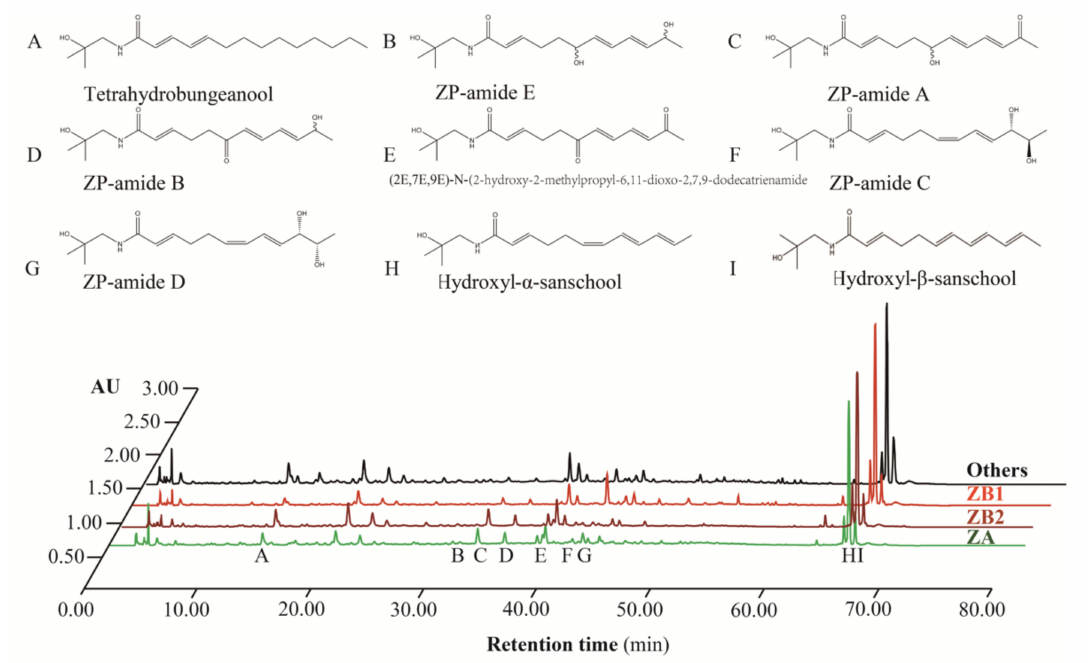
Figure 2. The relative abundance of alkylamides in different prickly ash species. AU represents absorbance unit; the peaks without labels indicate non alkylamide com- ponents; ZP in alkylamides stands for Z. piperitum ; ZA represents Z. armatum ; ZB1 samples are derived from Z. bungeanum from Hancheng; ZB2 samples are from Z. bungeanum from Fengxian; Others refers to the rest of the samples that have red pericarps, but do not derive from Z. bungeanum